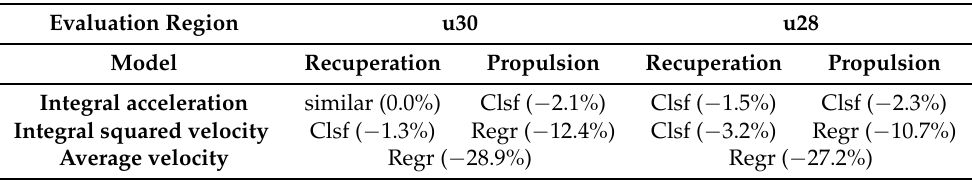
Table 4. Evaluation showing which model performs better in DPMAD prediction separately for each DPMA including deviation in